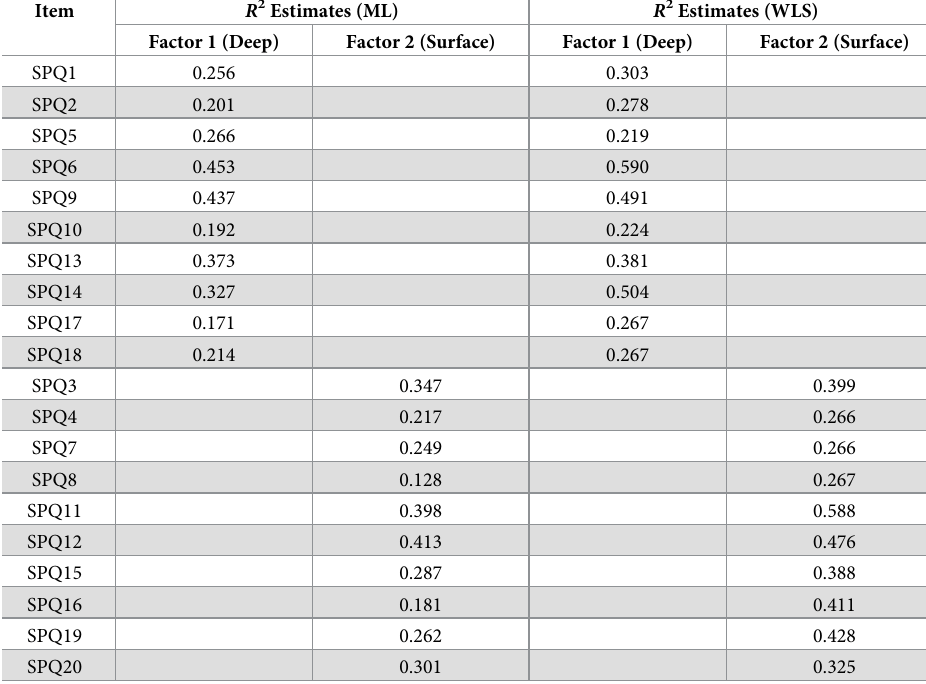
Table 7. R 2 values for each of the twenty items on the R-SPQ-2F.